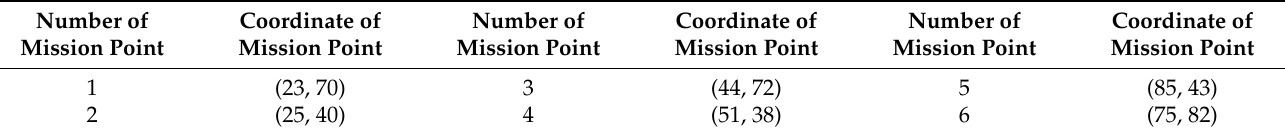
Table 18. Coordinates of mission point in the disaster rescue evaluation experiment.